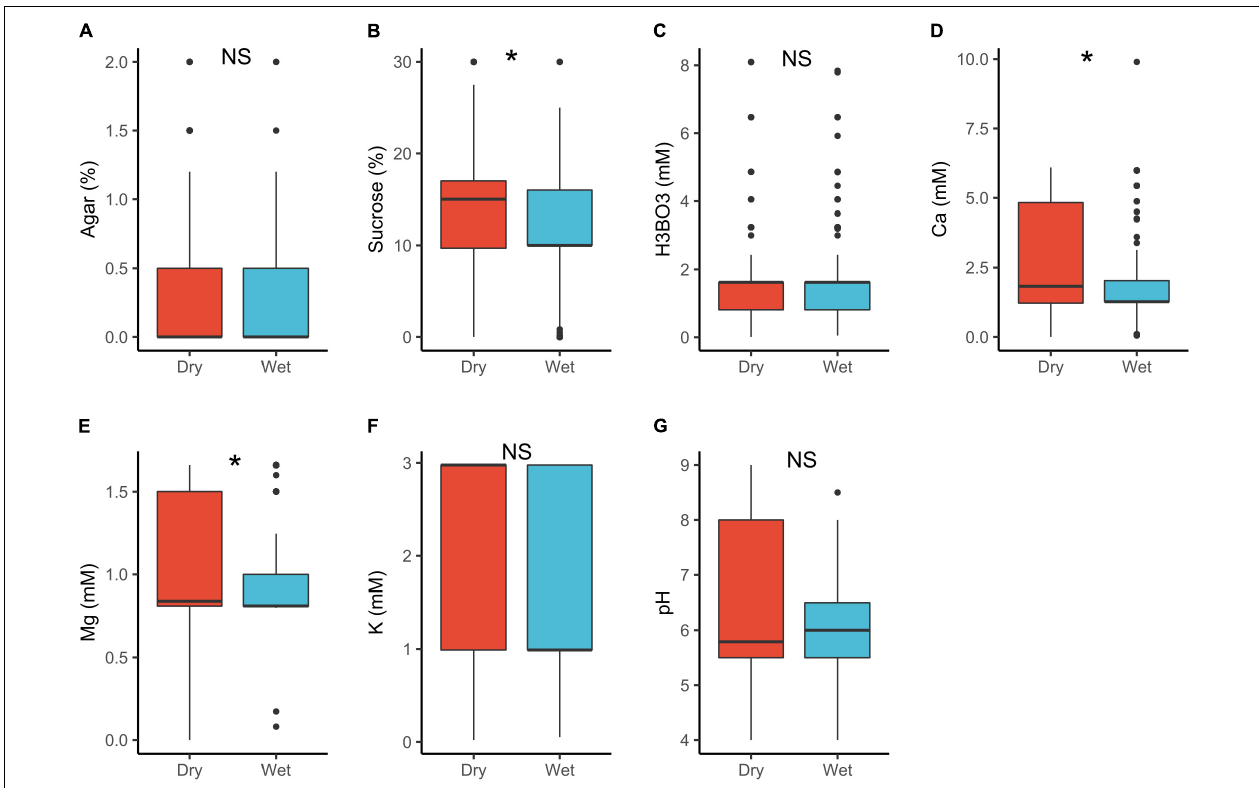
FIGURE 5 | Pollen germination media requirements for dry stigma ( n = 604) and wet stigma plants ( n = 475): agar (A) , sucrose (B) , boric acid (C) , calcium (D) , magnesium (E) , potassium (F) , and pH (G) . *, significant ( p < 0.05); NS, not significant.